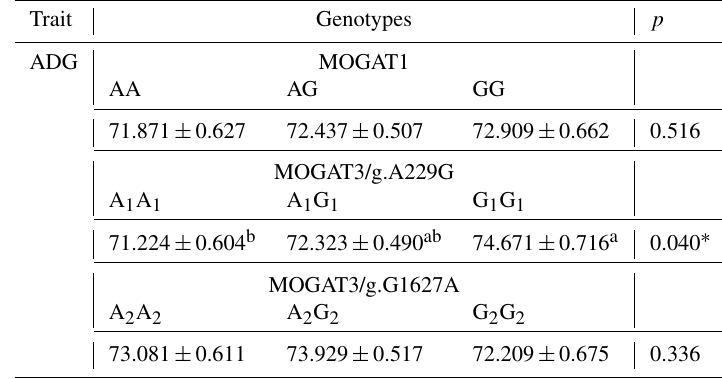
Table 4. Association analysis of genotypes and ADG according GLM. Trait